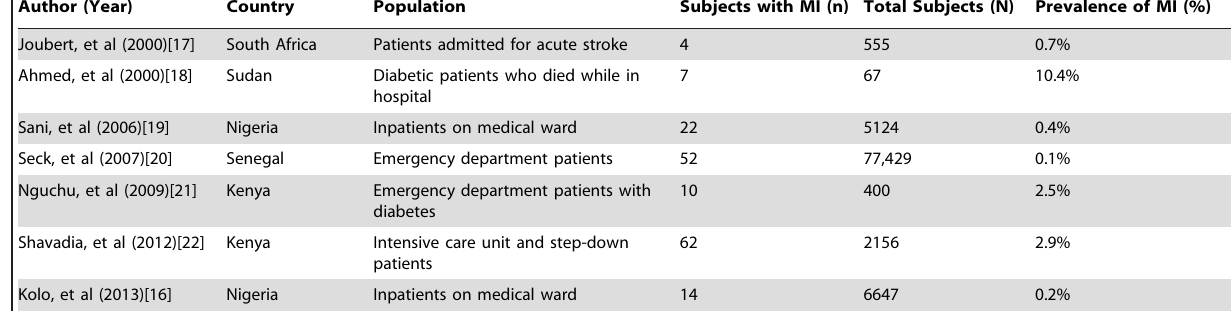
Table 2. Prevalence of MI among study populations of included studies.